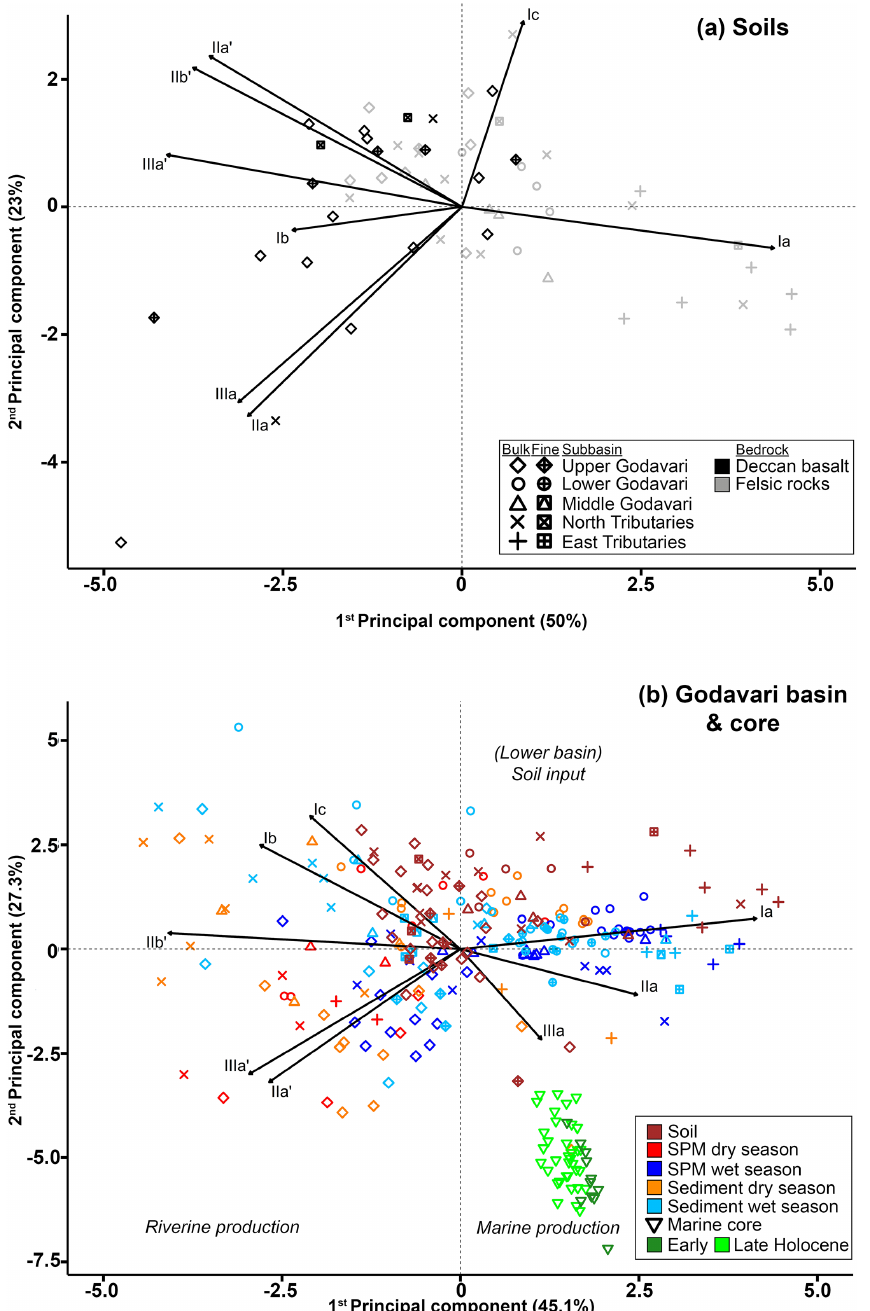
Figure 6. Principal component analysis (PCA) of the eight major brGDGTs (i.e. Ia, Ib, Ic, IIa, IIa (cid:48) , IIb (cid:48) , IIIa, and IIIa (cid:48) ). (a) PCA for soils formed on Deccan basalts (black) and felsic bedrock types (grey) (PC1 versus PC2). (b) PCA for SPM and bulk riverbed sediments collected in the wet and dry season (PC1 versus PC2), to which PCA scores of the bulk soils and Holocene marine sediments are added passively. The latter implies that the PCA calculation and biplot configuration is based on brGDGT distributions in river SPM and sediments (i.e. active samples), to which the scores of soils and marine sediments (i.e. passive samples) are added as an overlay. The vectors indicate the PCA scores of the individual brGDGTs. The symbols refer to the different subbasins and the different fractions (bulk and fine fractions ≤ 63µm) (see legend a ). The colours refer to the different sample